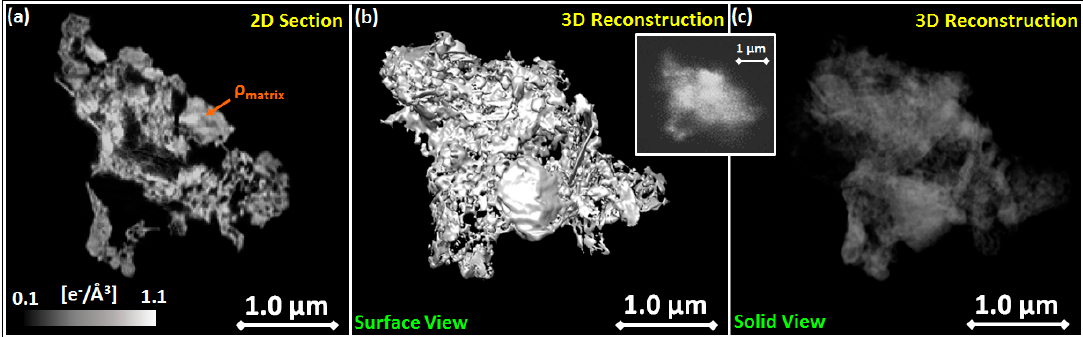
Figure 2. Coherent X-ray diffraction imaging (CXDI) reconstruction of a TiO 2 gig-lox portion representing: ( a ) central section showing the density ρ matrix being smaller than anatase; ( b ) 3D reconstruction showing the morphology of the sample at its surface (surface view) and ( c ) 3D reconstruction based on the integrated electron density (see also Figure 5). Inset: Environmental Scanning Electron Microscopy (ESEM) image used as benchmark of the CXDI reconstruction.